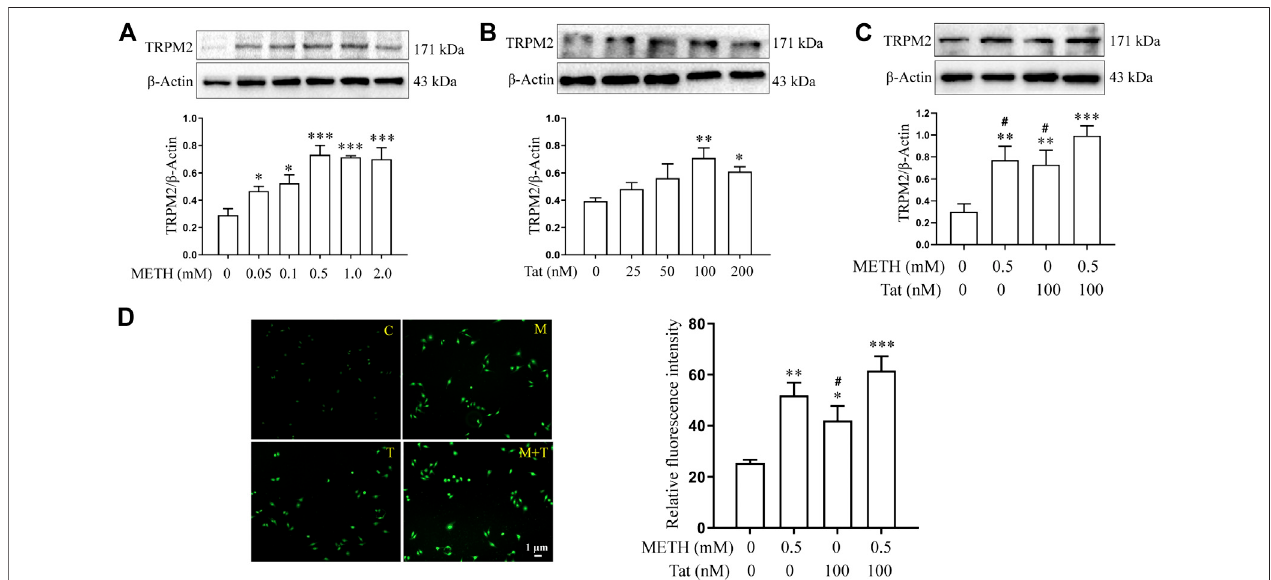
FIGURE4| METHandHIV-TatsynergisticallyactivatetheTRPM2channel. (A,B) WesternblotwasperformedtodetermineTRPM2expressionlevelinthehCMEC/ D3 cells treated with a gradient concentration of METH or HIV-Tat for 24 h. After the cells were treated with 0.5 mM of METH and/or 100 nM of HIV-Tat for 24 h, (C) western blot was performed to determine the TRPM2 expression level; (D) the Ca 2+ fl uorescence was observed using an inverted fl uorescence microscope (Scale bar: 1 µm), and the fl uorescence intensity was analyzed using Image J software. Compared with the control, * p < 0.05, ** p < 0.01, *** p < 0.001; compared with the METH + HIV-Tat, # p < 0.05, n (cid:1) 3. C (cid:1) Control, M (cid:1) 0.5 mM of METH, T (cid:1) 100 nM of HIV-Tat, and M + T (cid:1) 0.5 mM of METH+100 nM of HIV-Tat. The Ca 2+ fl uorescence shown in (D) was detected after the cells were treated with 0.5 mM of METH and/or 100 nM of HIV-Tat for 0.5